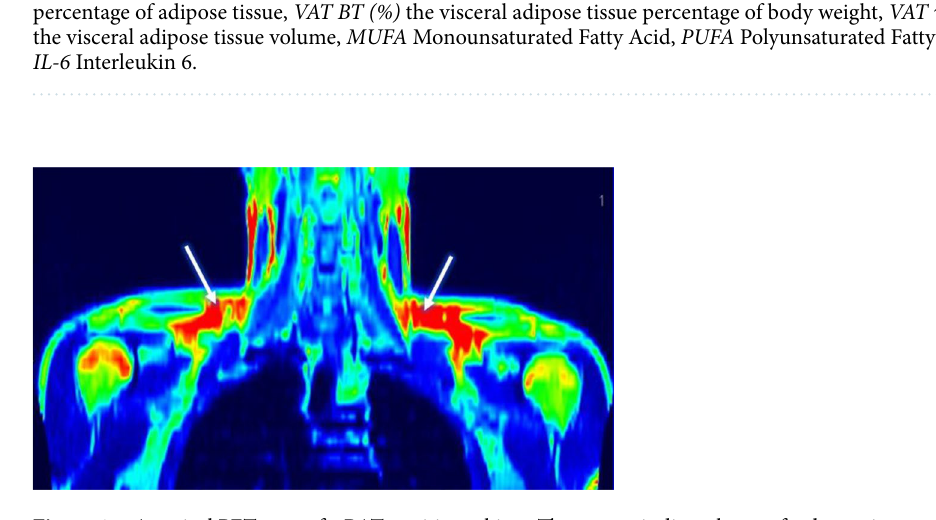
Figure 1. A typical PET scan of a BAT-positive subject. The arrows indicate brown fat depots in supraclavicular